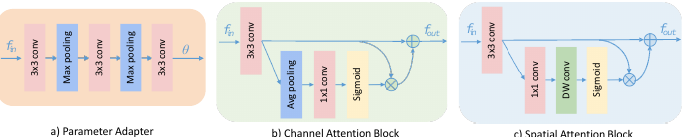
Figure 5. The architecture of the dynamic information transfer module.